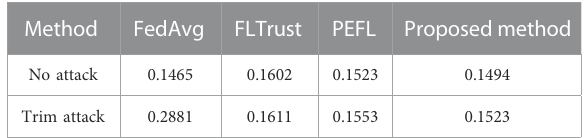
TABLE 3 Test error